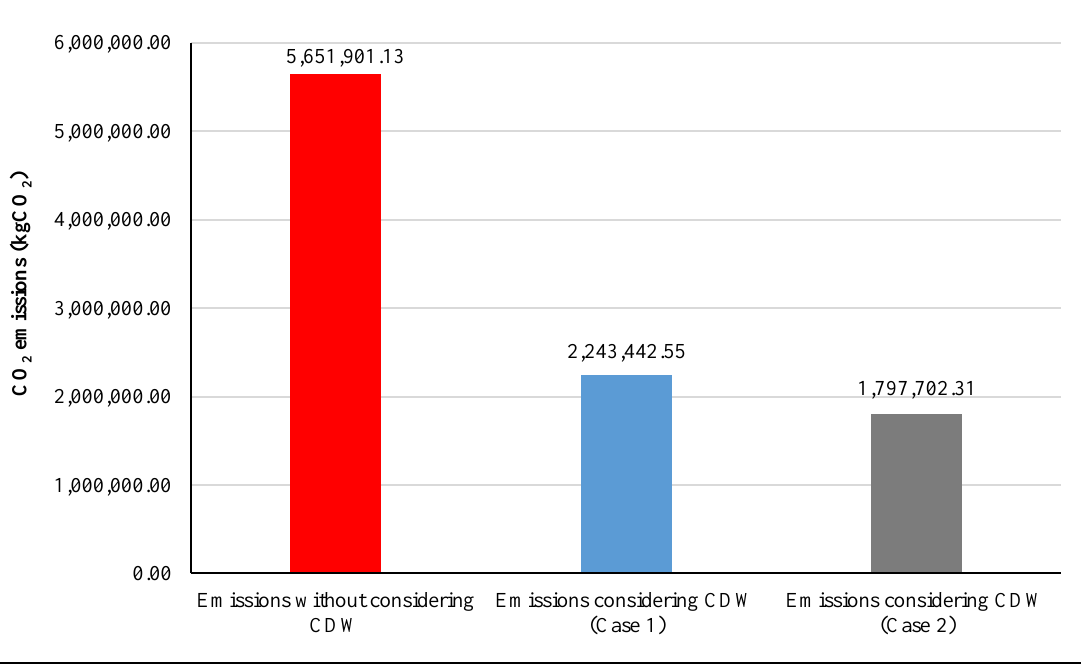
Figure 5. CO 2 emissions for implementing CDW practices at the construction